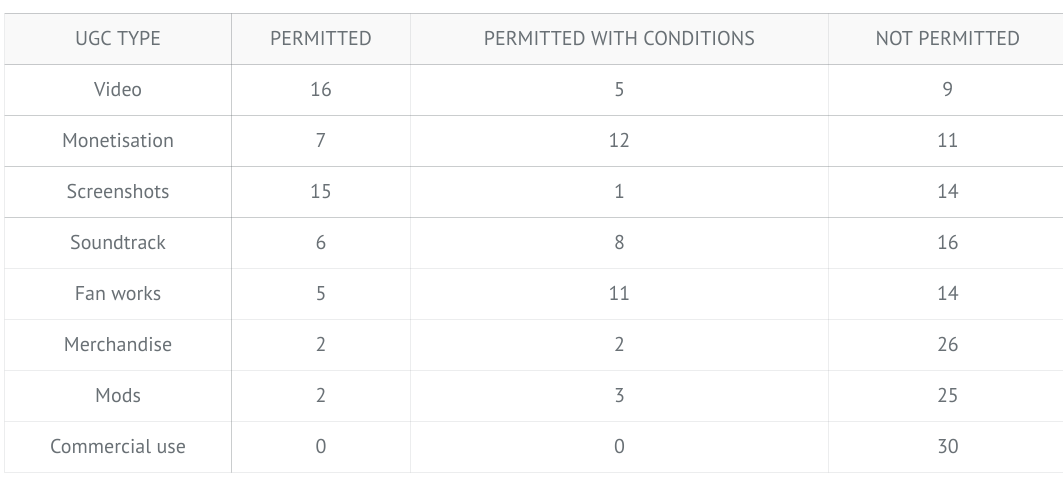
TABLE 1: Level of permission by